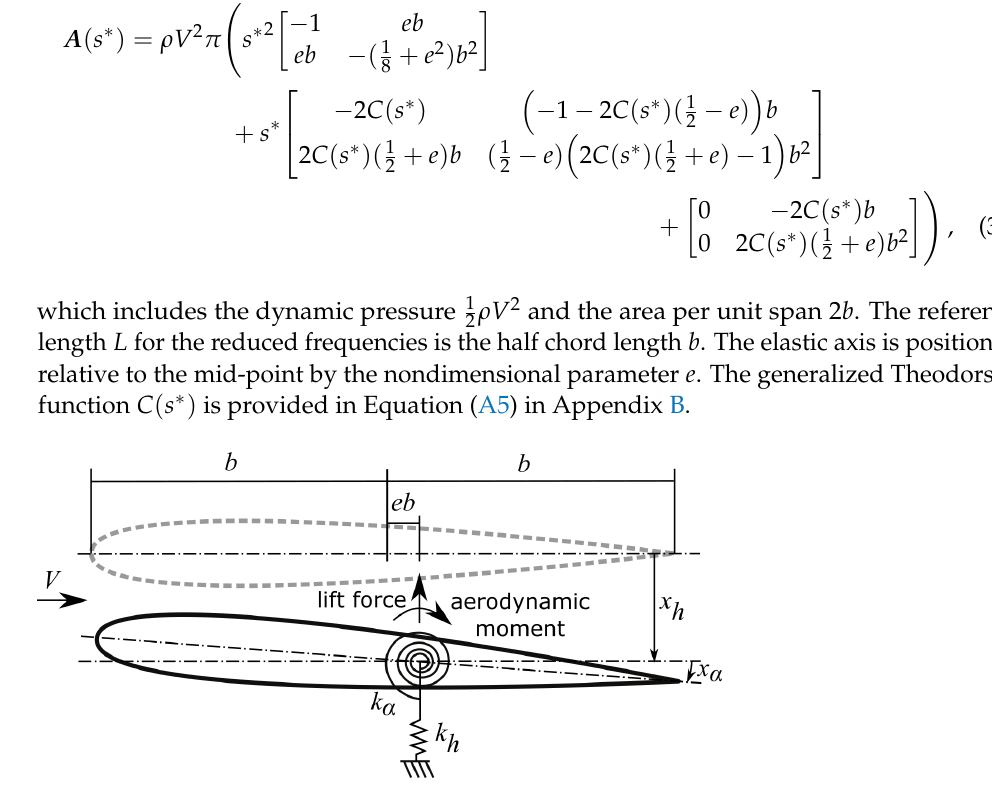
Figure 1. Sketch of the 2-DOF typical section model with elastically restrained plunge and pitch degree of freedom illustrated by an